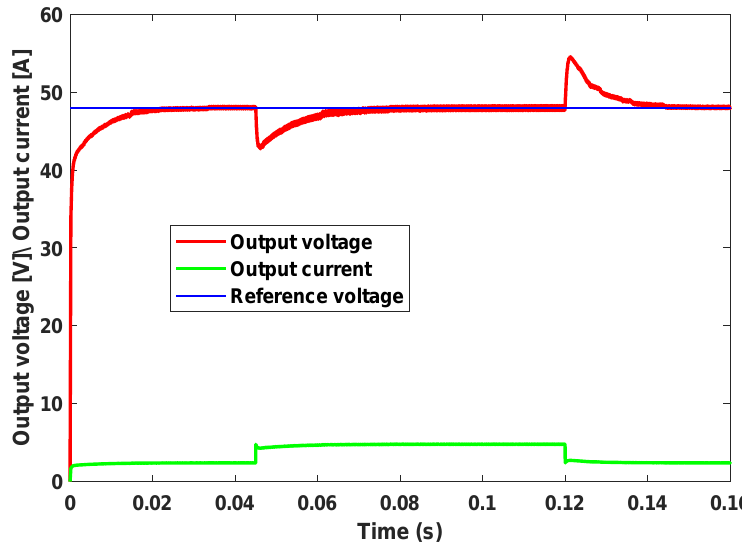
Figure 12. Transient response of recommended SMC in output voltage under load resistance step changes.